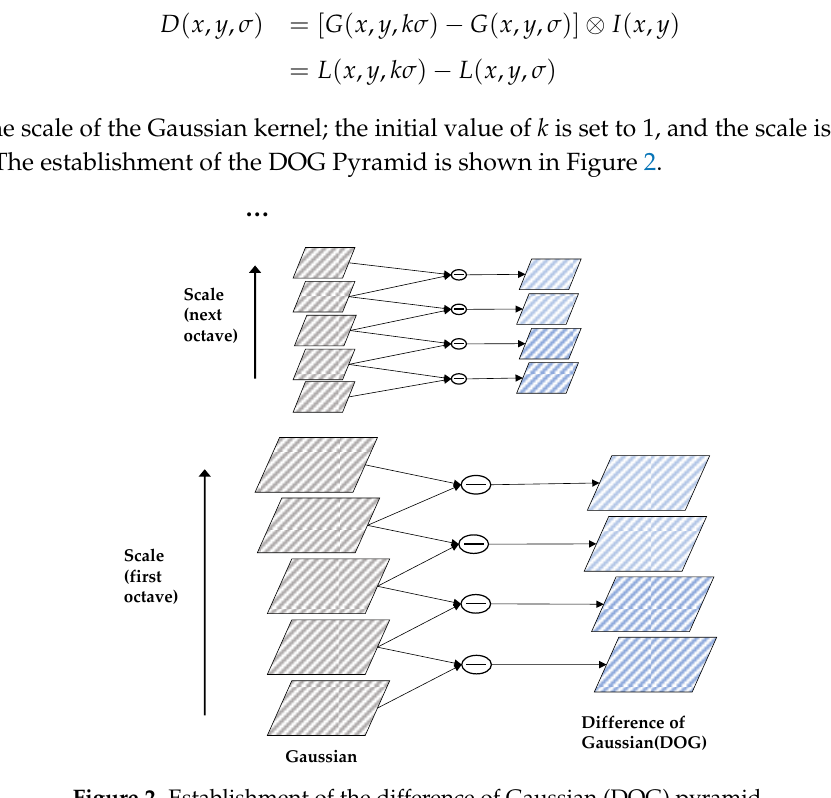
Figure 2. Establishment of the difference of Gaussian (DOG)